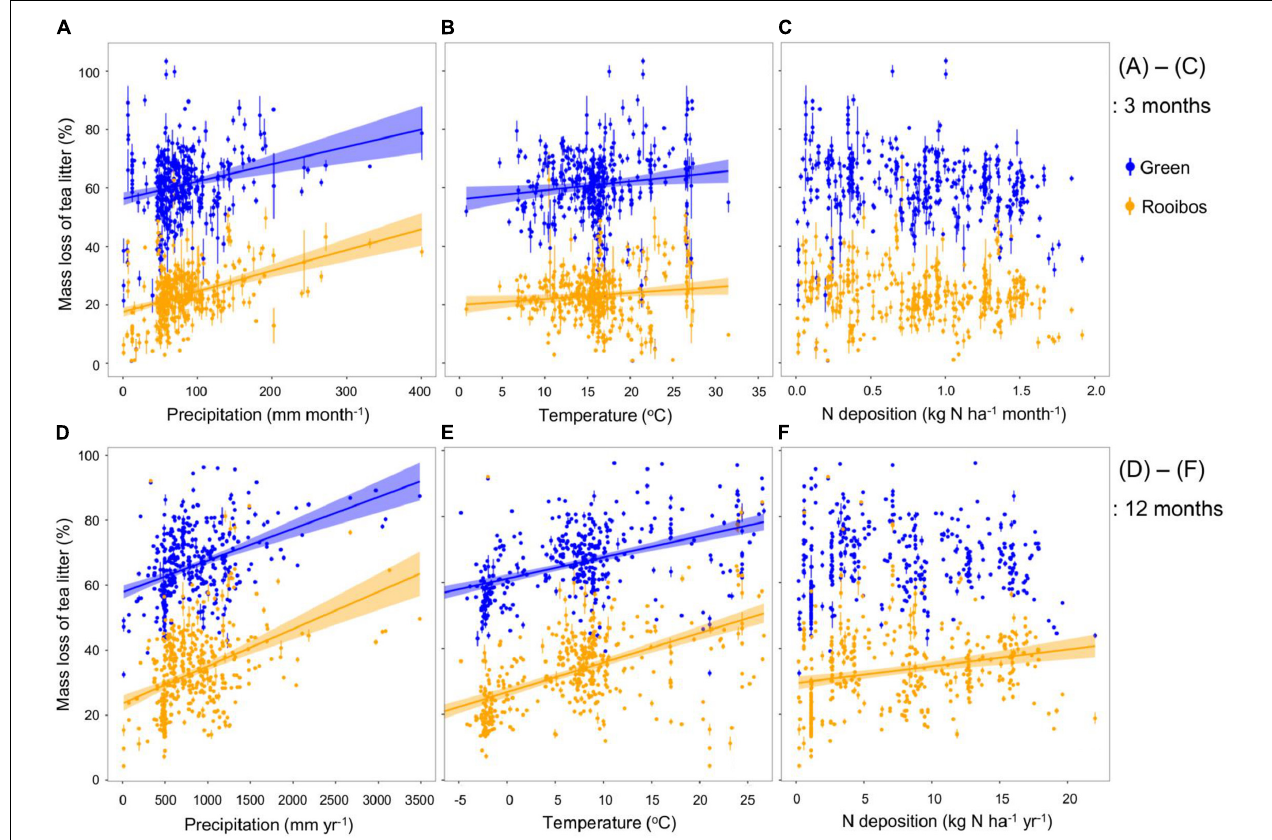
FIGURE 3 | Relationships between mass loss of Green tea and Rooibos tea and precipitation (A,D) , air temperature (B,E) and N deposition values (C,F) after 3-month (A–C) and 12-month (D–F) incubation periods in all biomes. Blue and orange circles show the means and the bars are the standard errors based on the total number of observations. Climatic variables and N deposition were obtained from CHELSA ver. 1.2 and ACCMIP dataset, respectively. Band shows 95% confidence interval. Relationships without regression lines show non-significant relationships.